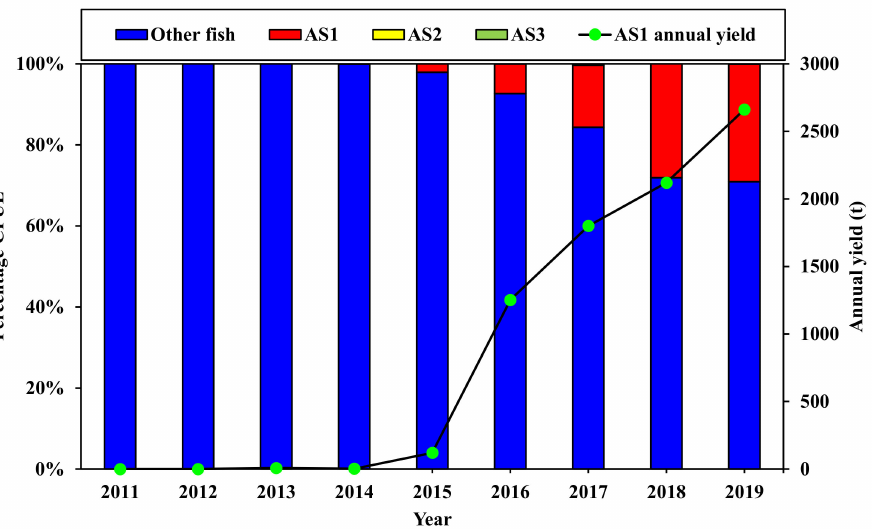
Figure 4. The mean catch per unit effort (CPUE) is plotted for each calendar year for three invasive species (AS1 = Japanese smelt; AS2 = Southern catfish; AS3 = Catfish) and other fish. Annual yield data (AS1) were derived from the literature